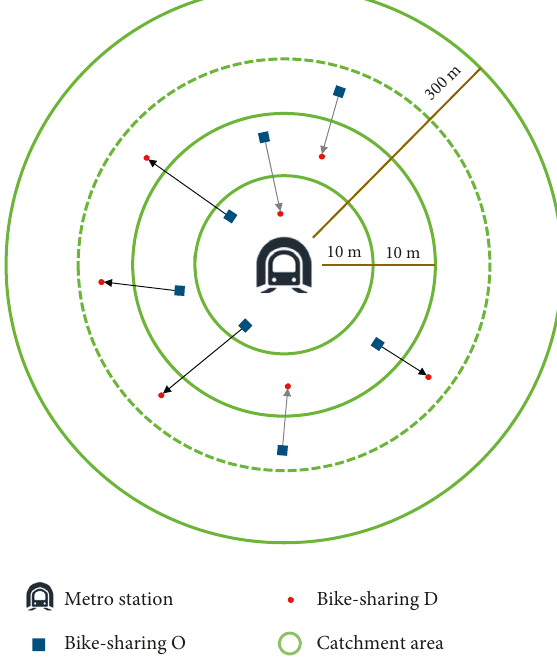
Figure 2: Catchment area for identifying transfer trips between bike-sharing and metros.